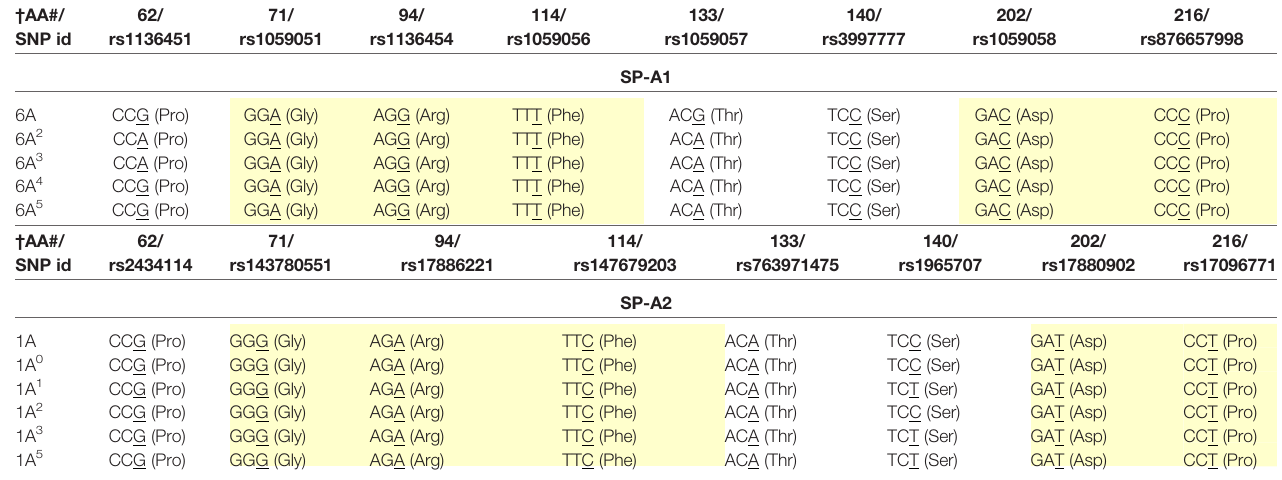
TABLE 3 | Nucleotide differences between or among SP-A1 and SP-A2 coding variants that do not change the encoded amino acids.